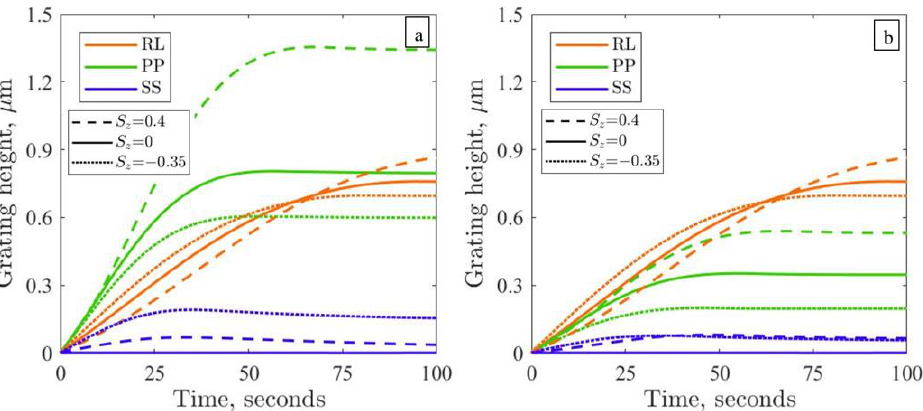
Figure 3. Modeled time-dependent growth of SS, PP and RL gratings at periodic BCs along the y -axis for different initial backbone orientations: ( a ) in the absence ( γ = γ 0 = 0.01 s − 1 ) and ( b ) presence of photosoftening ( γ is given by Equation (5)). The film thickness is 1 µ m. The initial light-induced stress is 25 MPa.